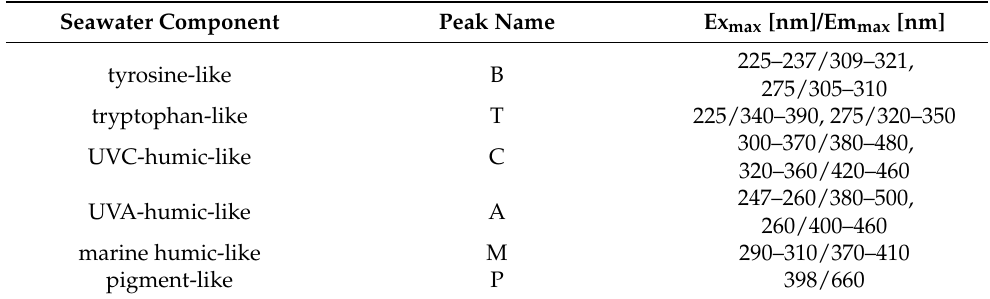
Table 3. Major fluorescent components of seawater with their wavelength-independent fluorescence maxima ( λ Ex / λ Em ) [18,25–27].